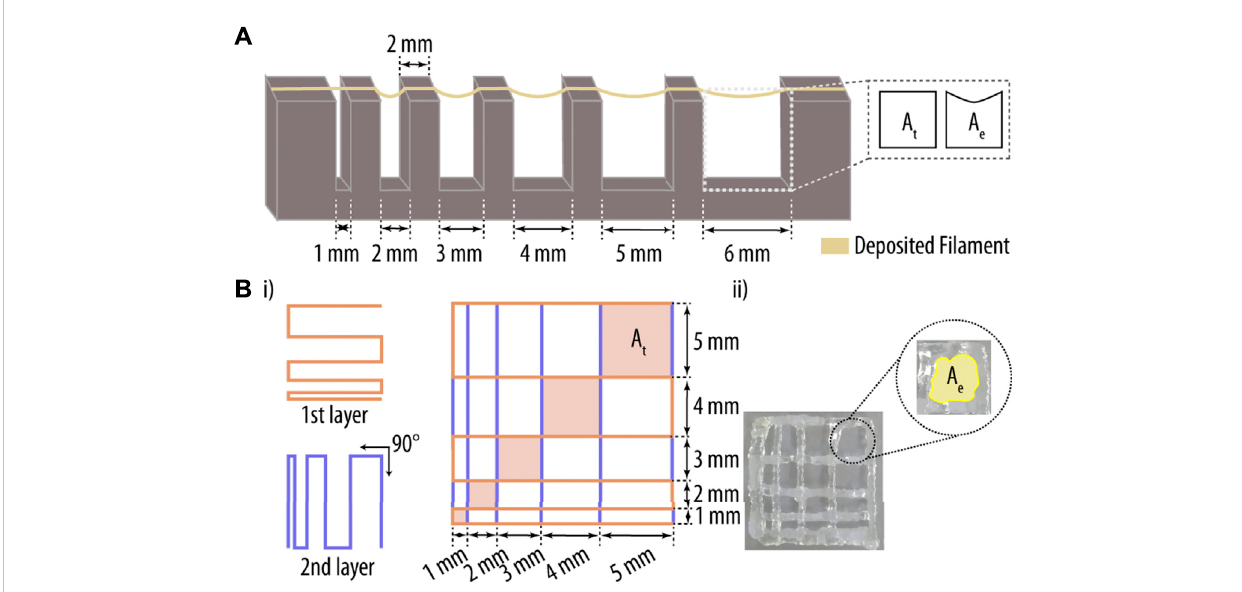
FIGURE 1 Printability assessment of hydrogel-based inks. (A) Three-dimensional (3D) printed platform used for the evaluation of the fi lament collapse area. While A e represents theexperimentallydetermined area, A t correspondsto thetheoreticalarea undertheprinted fi lament. (B) (i) Printing patternused for the fi lament fusion test. Two fi lament layers were deposited along 0 ° and 90 ° , and the resulting areas between fi laments (A e ) were measured and compared to their theoretical counterparts (A t ). Adapted with permission. [37] Copyright 2018,